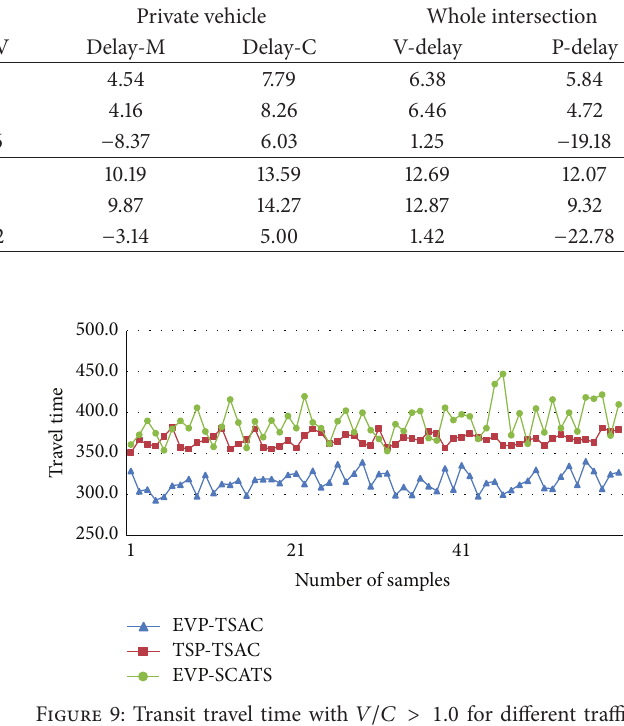
Table 2: The performance indices of transit vehicle and private vehicle at 0.8 < 𝑉/𝐶 ≤ 1.0 . Traffic condition